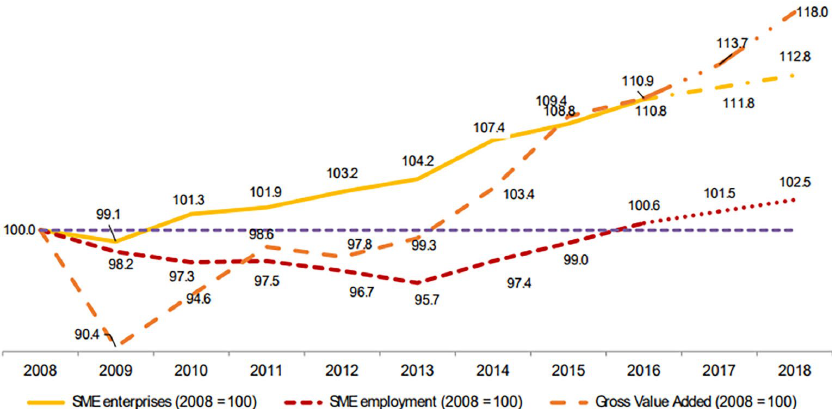
Figure 1. Recovery of European SMEs since financial crisis (source: European Commission,